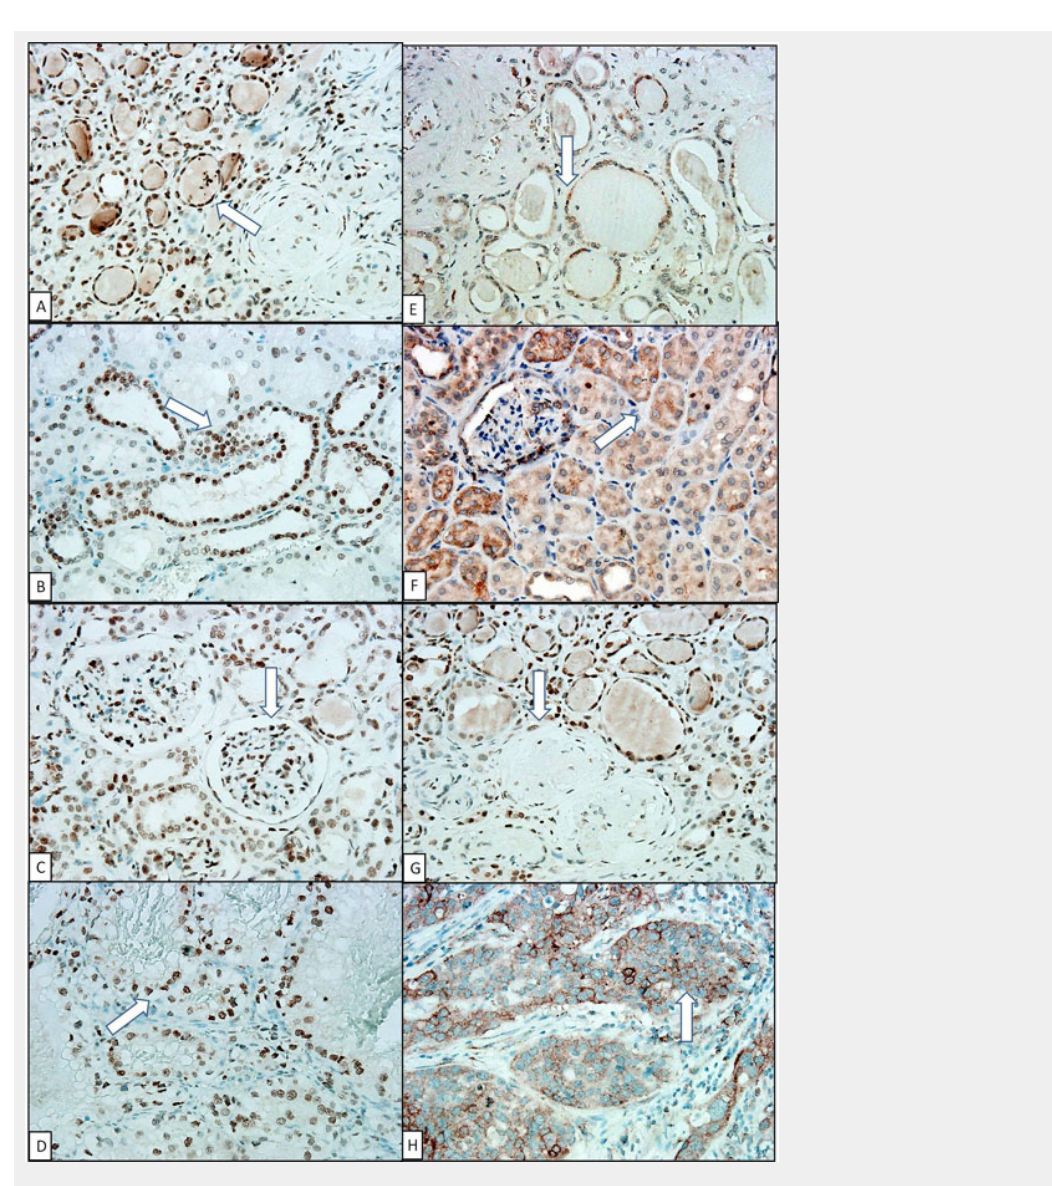
Figure 1 High expression of 8-OHdG in (A) atrophic tubular nucleus; (B) normal tubular nucleus; (C) normal glomerular nucleus; low expression of 8-OHdG in (E) atrophic tubular cytoplasm; (F) normal tubular cytoplasm; (G) sclerotic glomerular nucleus (negative control); and 8-OHdG expression in RCC nucleus (D) and UCC cytoplasm (H) (positive control). (Arrow indicated the area of 8-OHdG expression) (IHC stain,